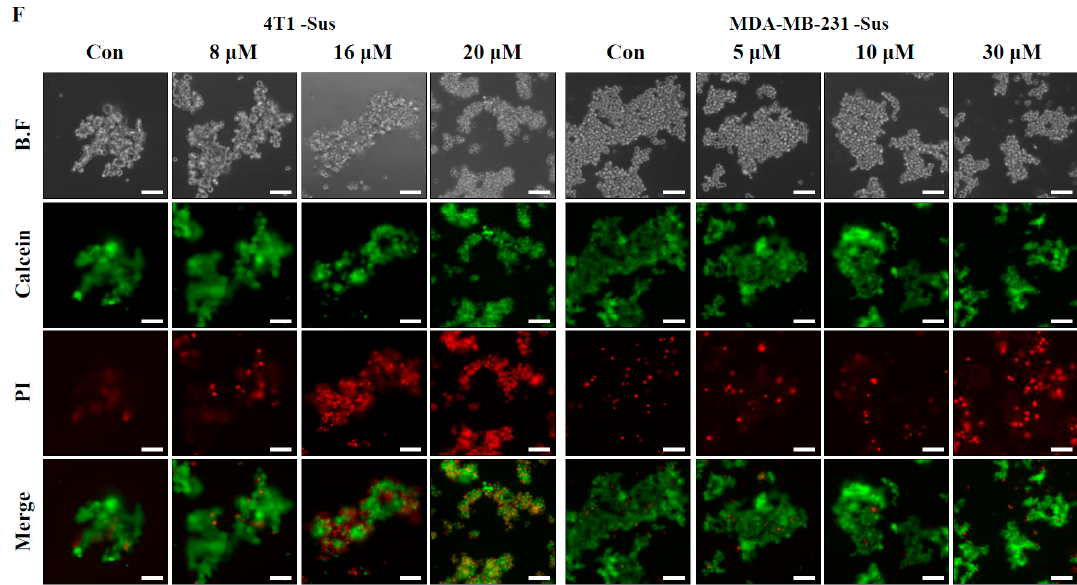
Figure 1. E ff ects of pygenic acid A (PA) on cell growth and anoikis in metastatic breast cancer cell lines. ( A ) Structure of pygenic acid A (PA) ( B ) 1 × 10 4 cells / well were seeded for 24 h, and then treated with indicated concentrations (0–20 µ M) of PA for 24 h. Cell proliferation was measured with the IncuCyte ™ system. ( C – E ) Cells in either attachment or in suspension culture were treated with 0–50 µ M PA for 24 h. Cells were subjected to either MTS assay for cell growth ( C ), annexin-V / PI staining for apoptosis ( D ), or calcein-AM / PI staining for live / dead cell assay ( E ), as described in the Section 4. ( F ) Cells in suspension culture were treated with 0–30 µ M PA for 24 h and stained with calcein-AM / PI, followed by image capture using fluorescence microscopy (green: live cells; red: dead cells). Data are presented as mean values from three independent experiments, and error bars represent standard deviations. Error bars represent standard deviations of the mean of three measurements (* p < 0.05, ** p < 0.01), Magnification: 100 × , Scale bars = 100 µ m. Experiments were performed independently three times with comparable results.